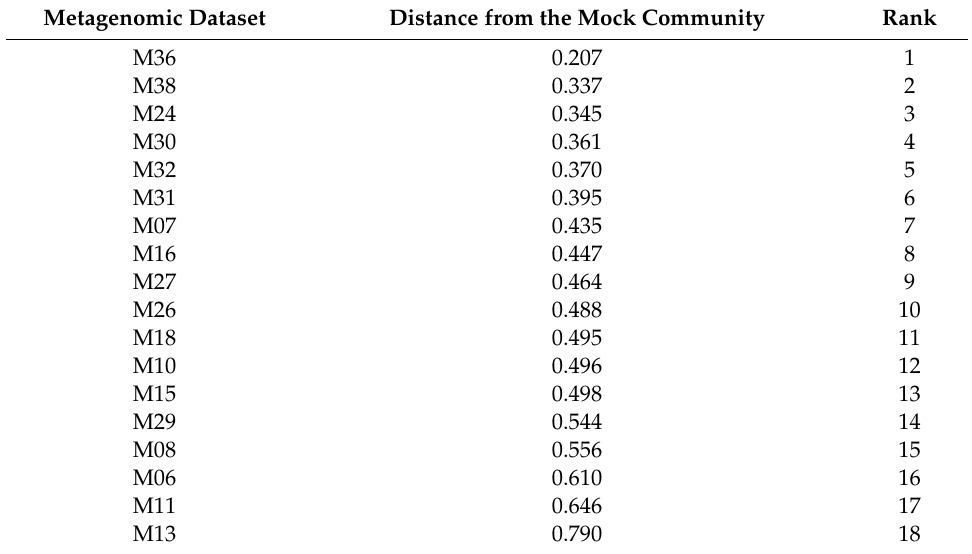
Table 4. Ranking of the DNA metagenomic datasets obtained testing spiked salmon in relation to their similarity to the expected composition of the mock community. The distance from the expected mock community composition is measured as Bray–Curtis